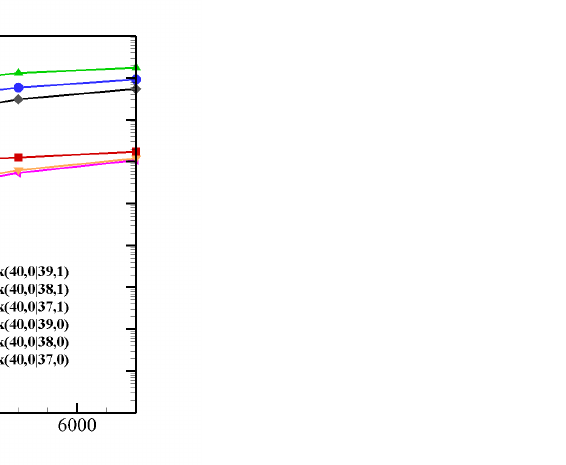
Figure 11. V–T/R and V–V rate coefficients for selected CO ( 40 ) + N 2 ( 0 ) processes as a function of temperature.